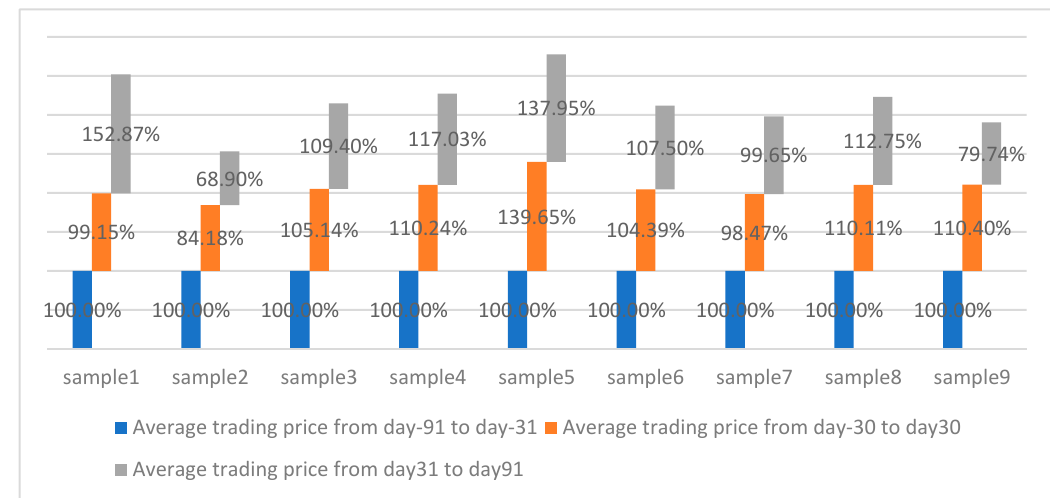
Figure 6 . The average price from day − 91 to day +91. Figure 6. The average price from day − 91 to day